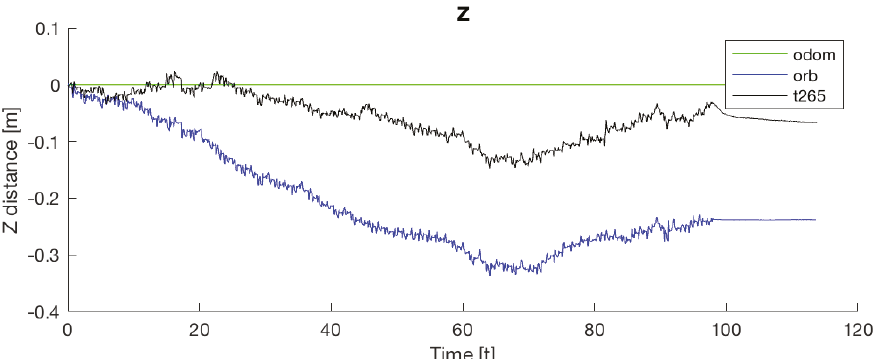
Figure 30. Outdoor uneven terrain #1. Walking straight test. Absolute errors.